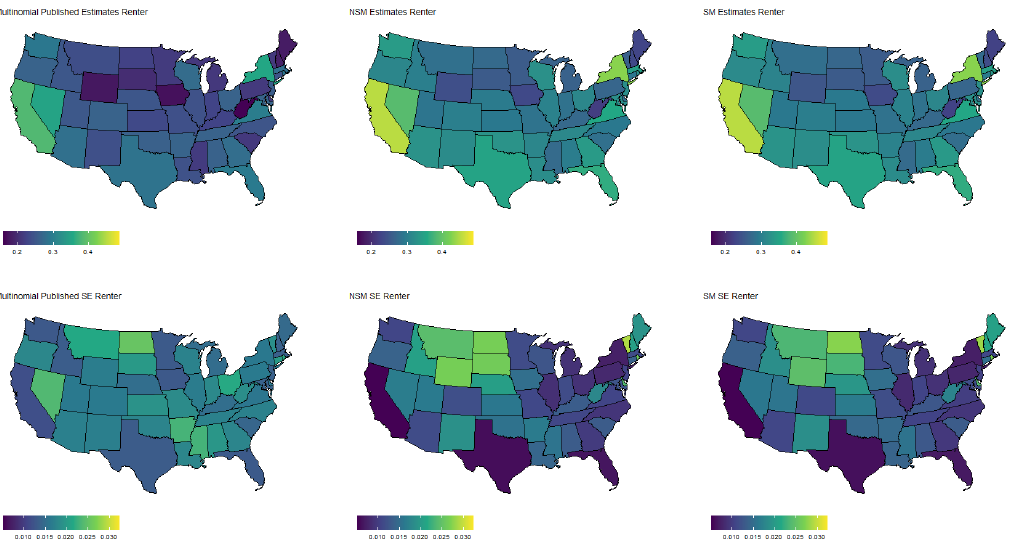
Figure 6. Estimated population proportion of people who pay rent by state and estimator along with corresponding standard error in Week 1 of the Household Pulse Survey. Estimates are plotted on the same color scale, and SEs are plotted on another color